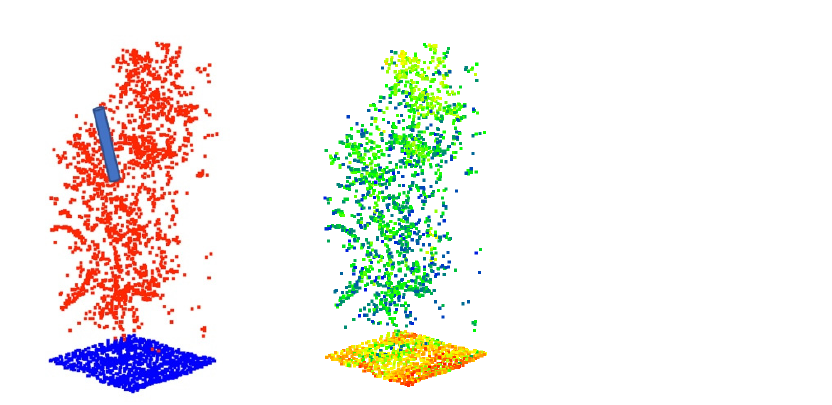
Figure 4. Sketch of a laser pulse in the canopy investigated in the example. In the left figure the return pulses are colored by classification into ground (blue) and vegetation (red), and in the right figure by intensity. All together 2,974 return pulses were available on the square with a side length of five meter.